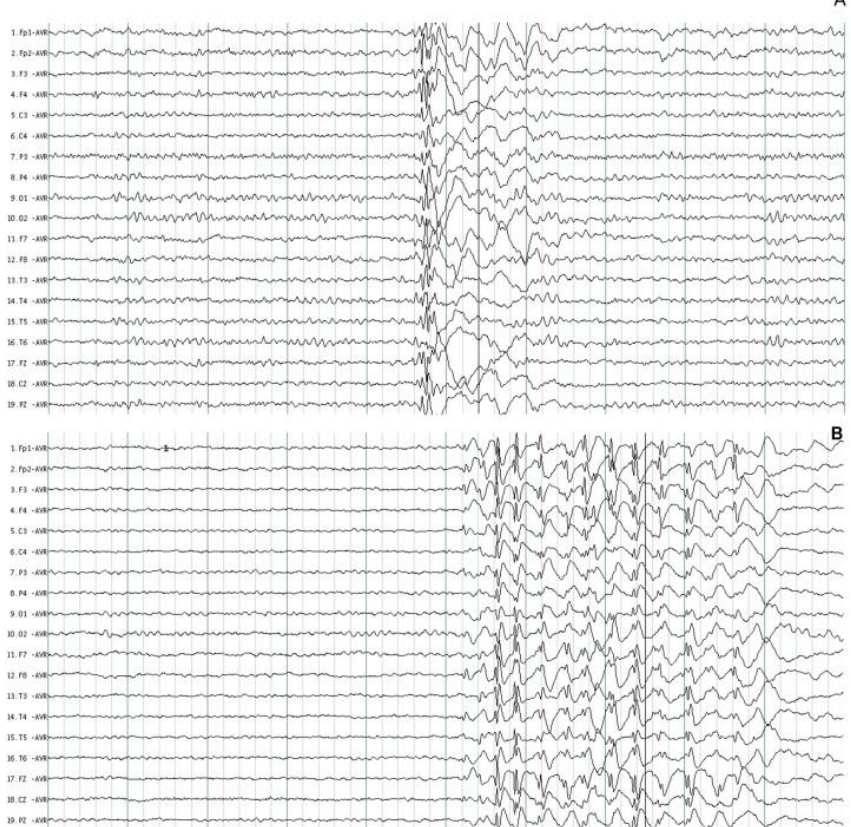
Figure 1. Typical paroxysmal activity in two patients with juvenile myoclonic epilepsy. ( A ) Polyspike and wave complexes of short duration. ( B ) Fast spike and wave complexes with more amplitude on the frontal leads. The normal background EEG activity was identified in two patients.